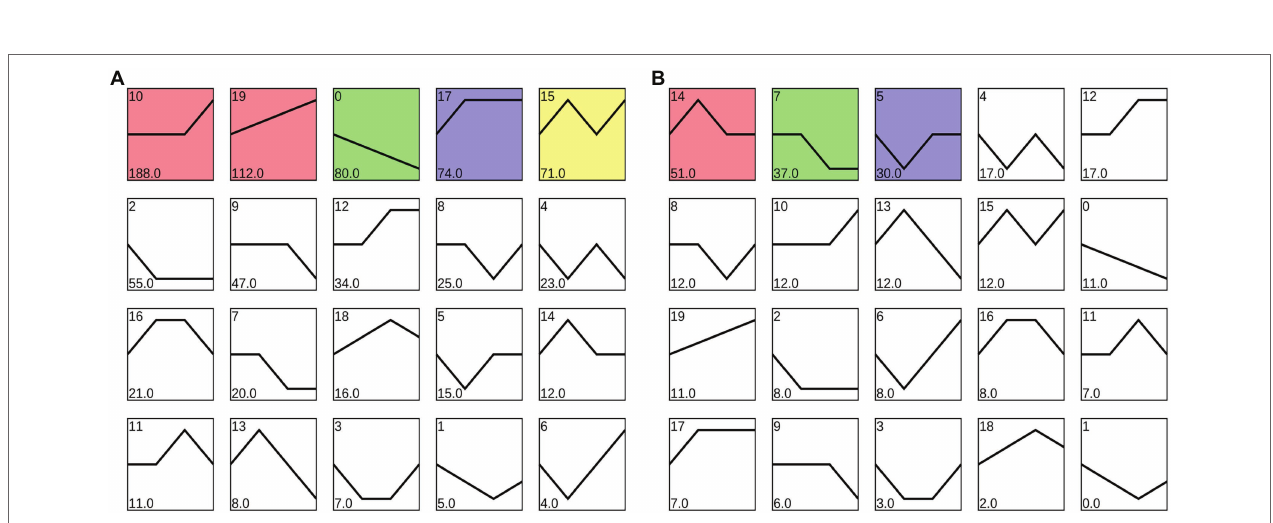
FIGURE 2 | Trend analysis of the differentially expressed target genes of specific miRNAs in (A) roots and (B) leaves, and profiles are ordered based on the number of genes